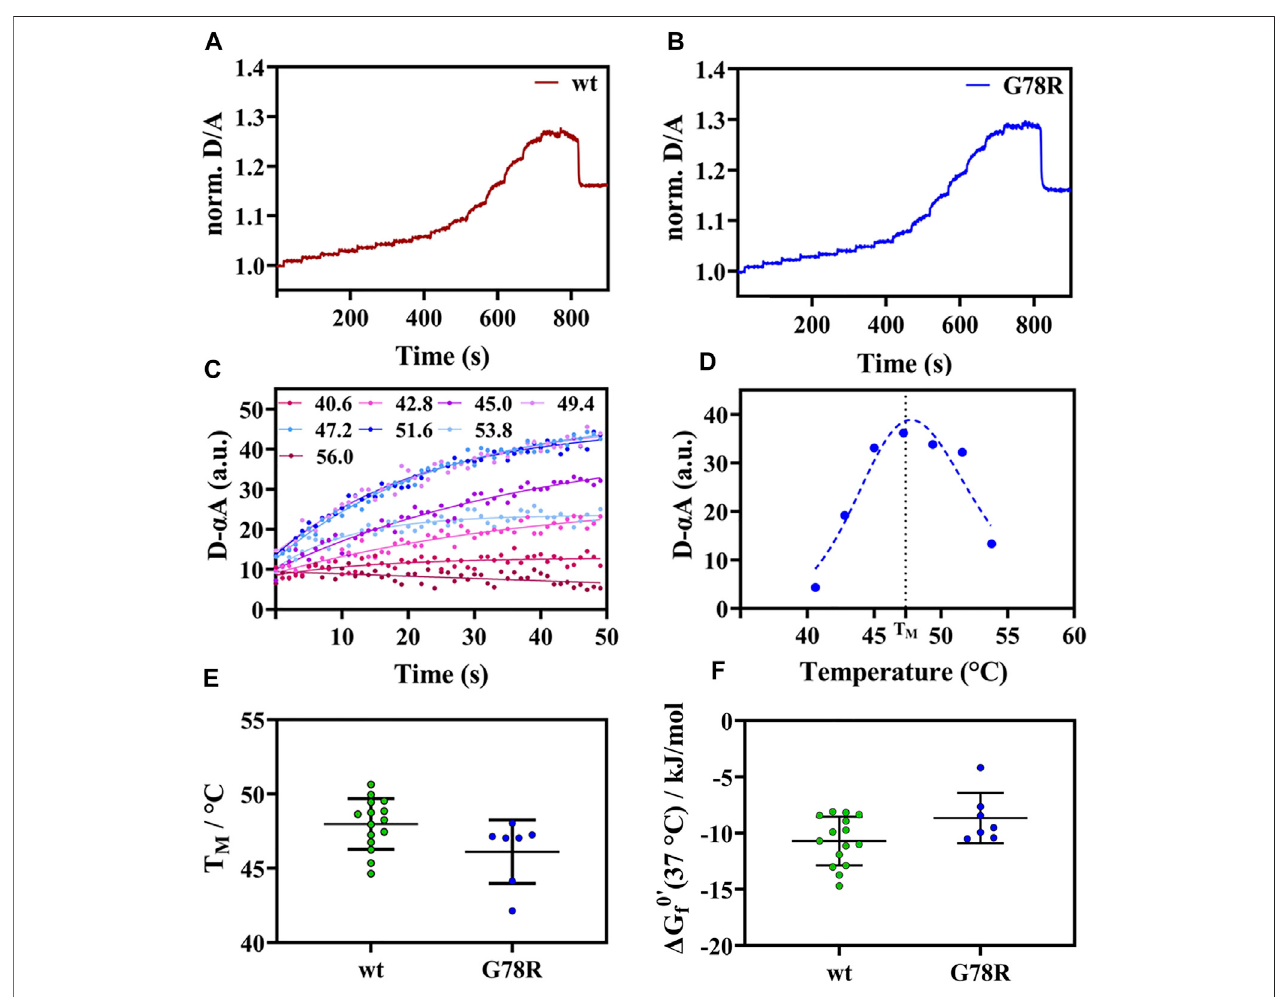
FIGURE2| ThermalunfoldingcurveAPSK37wtandmutants(G78R). (A) Exemplarytemperatureinducedthermalunfoldingcurvesofwt(datashownfrom(Brylski et al., 2021)). (B) Exemplary temperature induced thermal unfolding curves of G78R. (C) Exponential unfolding curves of single temperature jumps from panel (B) showing the relaxations kinetics at the respective temperatures. (D) Kinetic amplitudes as a function of temperature to determine the T m (dashed line). (E) Thermal stability comparison of the mutant G78R with APSK37 wt: Melting points of APSK37 (green) and melting point of G78R (blue) derived from FReI measurrement showingaverage±s.d. (F) Folding freeenergy Δ G f0 ’ forboth APSK37wtand G78Rmutant withmean ±s.d.There areno statistically signi fi cantdifferencesbetweenwt and G78R. Signi fi cance were tested via one-way ANOVA with a post-hoc Holm-Sidak test correcting for multiple comparisons (no signi fi cant changes observed).